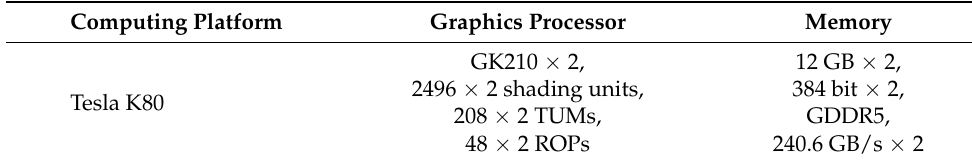
Table 1. Configuration of Tesla K80. Computing